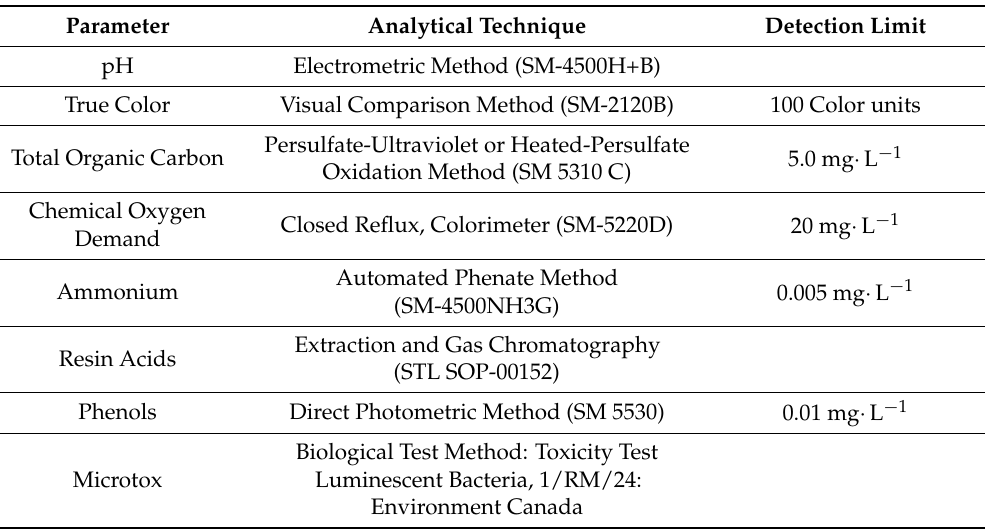
Table 1. Analytical techniques and detection limit where